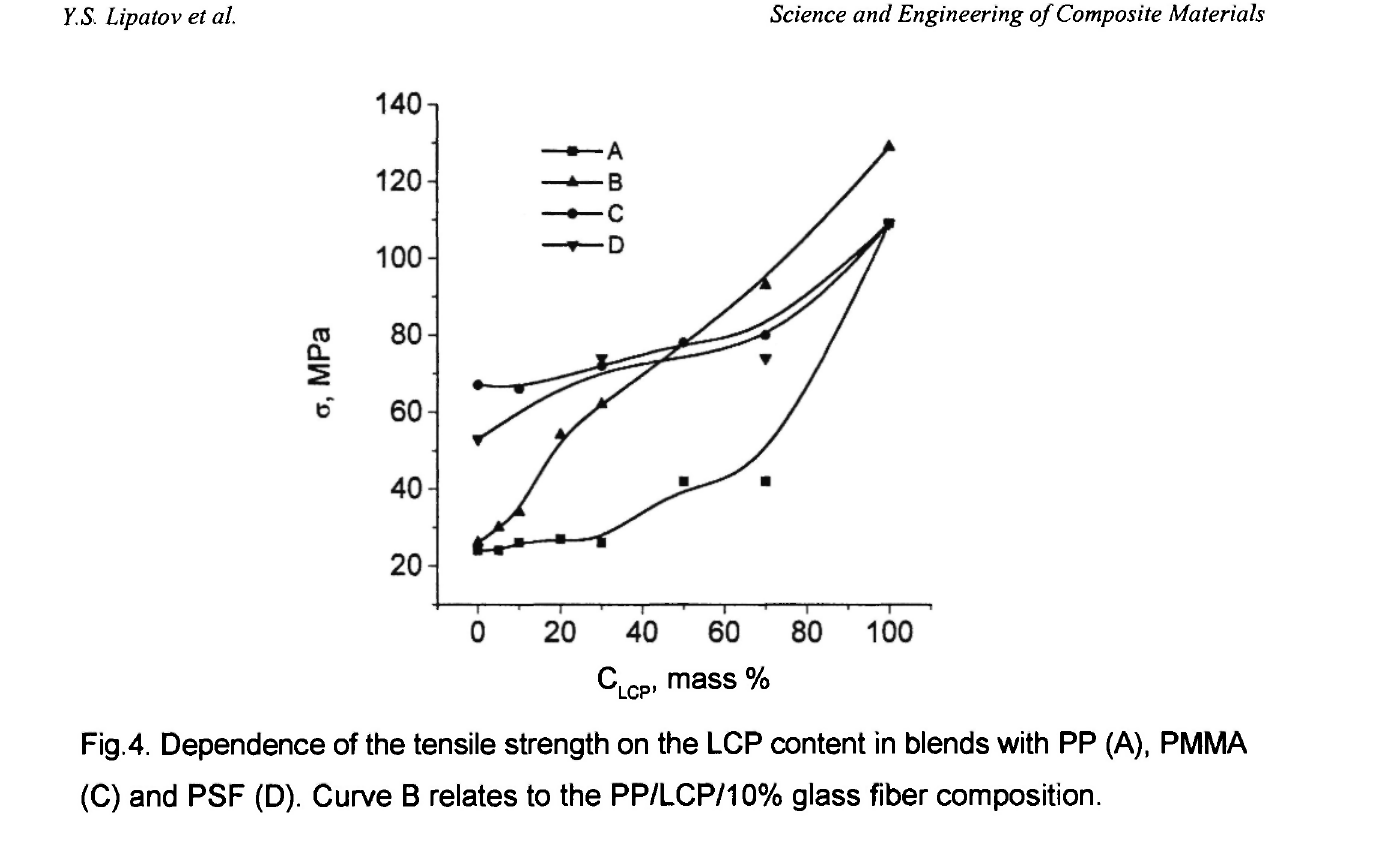
Fig.4. Dependence of the tensile strength on the LCP content in blends with PP (A), PMMA (C) and PSF (D). Curve Β relates to the PP/LCP/10% glass fiber composition.